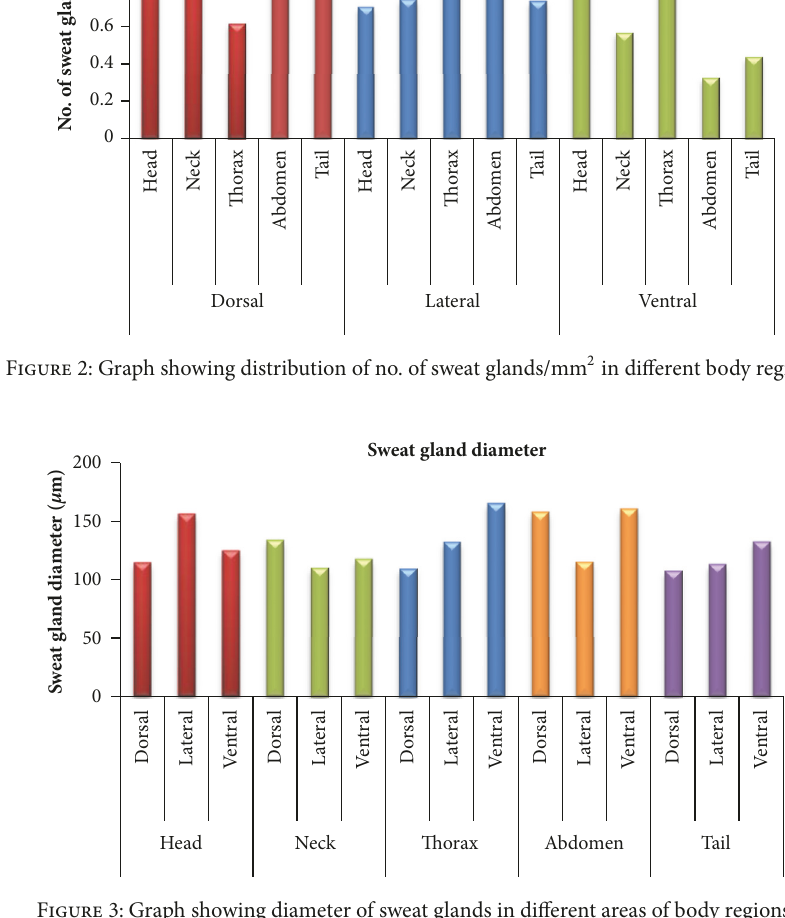
Figure 3: Graph showing diameter of sweat glands in different areas of body regions.